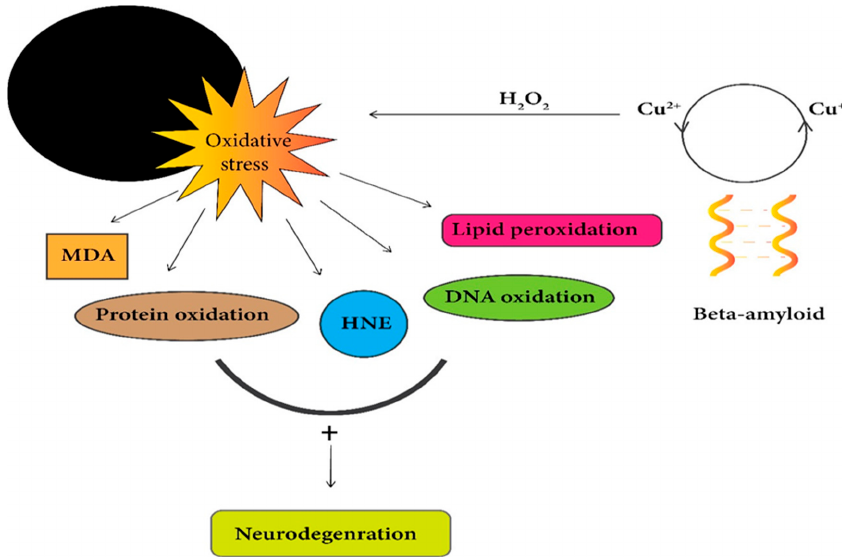
Figure 3. Redox cycling of Cu 2 + / Cu + with A β peptides leads to the production of hydrogen peroxide. Unstable reactive oxygen species (ROS) production from H 2 O 2 results in oxidative stress, leading to mitochondrial dysfunction, oxidative cellular damage, and neuronal loss. Cytotoxic end-products of lipid peroxidation malondialdehyde (MDA) and 4-hydroxy-2-nonenal (HNE) promote cell